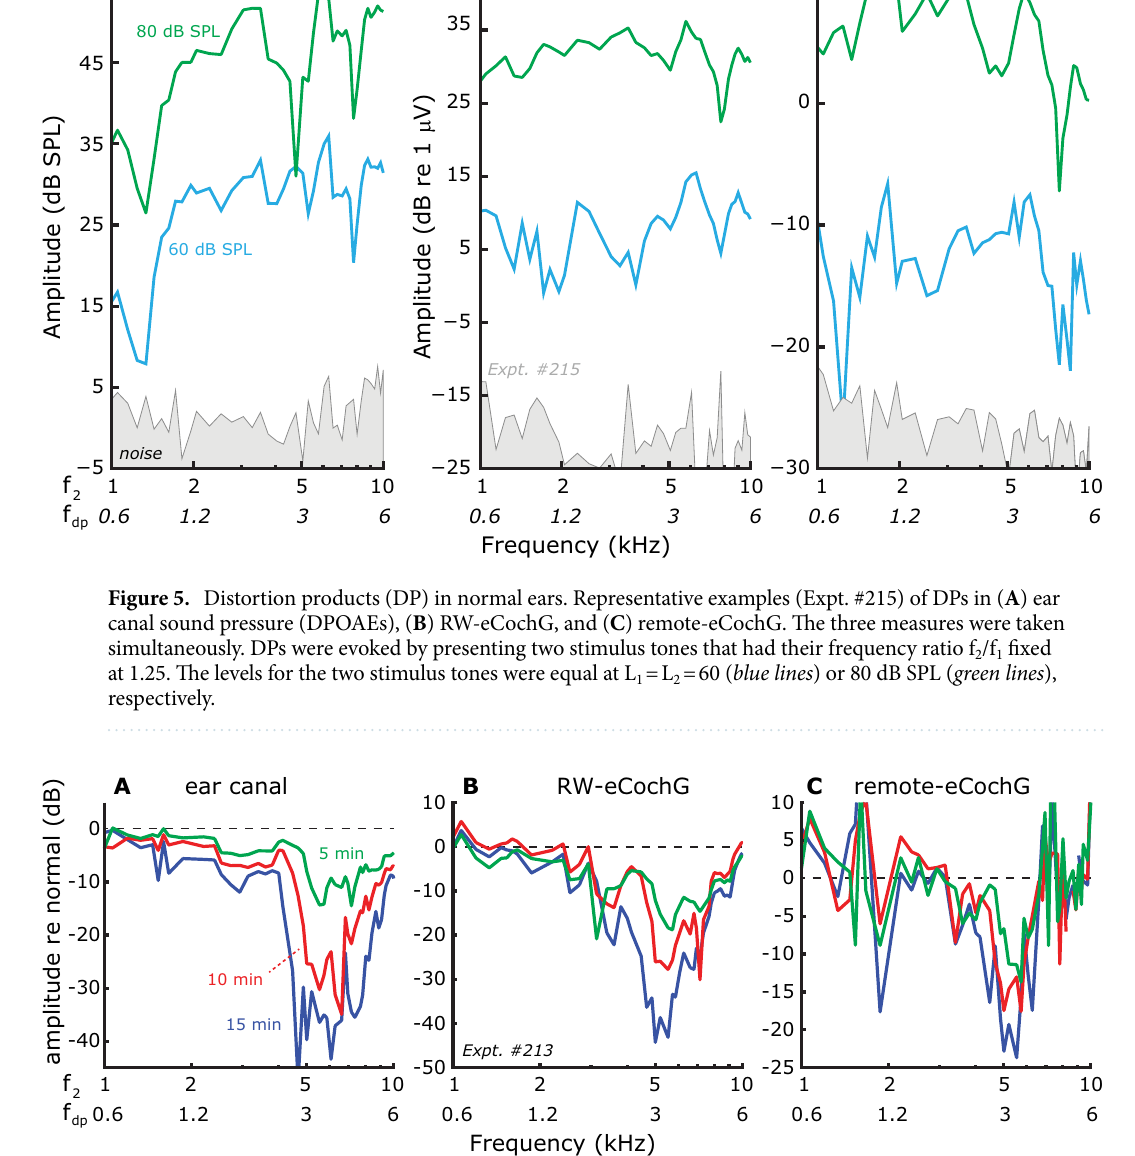
When using higher-intensity stimuli (L 1 = L 2 = 80 dB SPL), a different picture emerges (Fig. 7F–J). First, there is less reduction in DP amplitudes for all three measurements. Second, the DPOAE reductions are now bimodal (Fig. 7F) with local minima around 2f 1 -f 2 = 2 kHz (f 2 = 3–4 kHz) and 4 kHz (f 2 = 5–6 kHz), respectively. The change in eCochG-DP amplitudes (Fig. 7G, H) also show this bimodal dependence on frequency, but less pronounced: maximum reductions occur for 2f 1 − f 2 ≈2 kHz. The origin of this bimodal dependence is not obvious. It could arise from the selective abolishment of distortion-type and reflection-type DP components 18 but may also result from the interference of “CL” and “sub-CL” DP components. The latter would explain why the bimodal depend- ence is not as pronounced for L 1 = L 2 = 60 dB SPL, since “sub-CL” components become more important with increasing stimulus levels. At this higher intensity, the responses to the stimulus themselves are not affected by